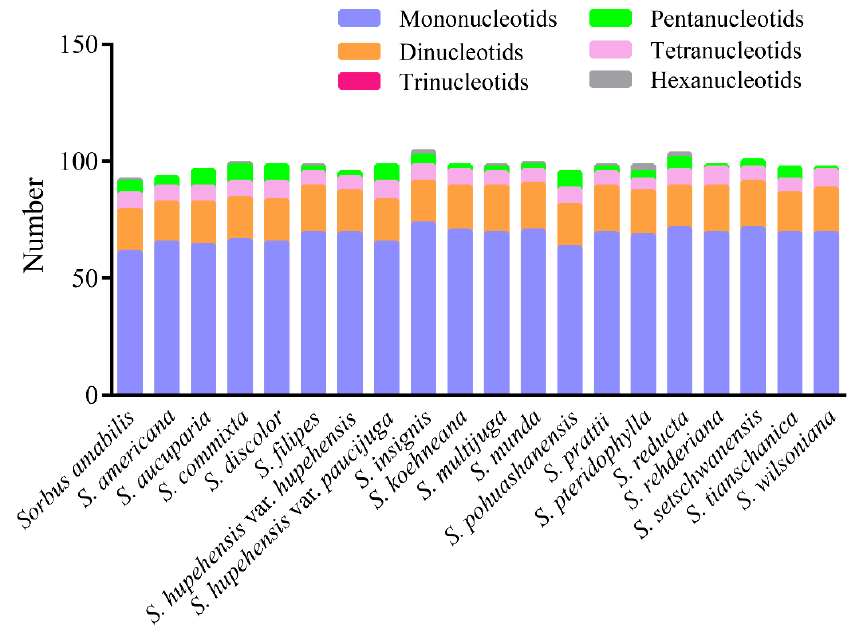
Figure 3. Number of six SSR types examined in the 20 Sorbus chloroplast genomes.